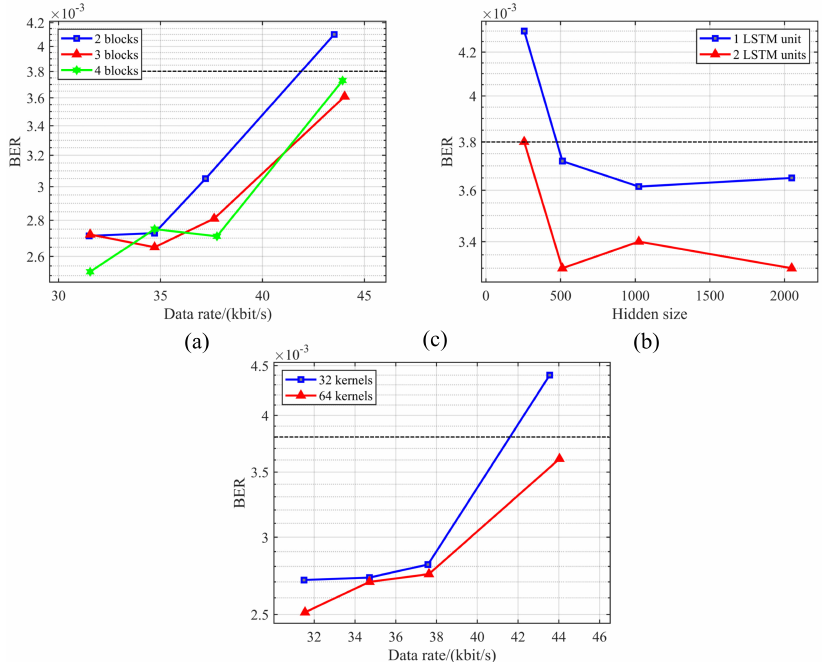
Figure 12. BER performance under different parameters of neural network structures. In addi- tion to the parameters investigated in each experiment, the other parameters are set as shown in Table 1. ( a ) Sensitivity of neural network performance to the quantity of blocks in encoder; ( b ) Un- der 46 kbaud/s, sensitivity of neural network performance to the quantity of hidden neurons and layers of LSTM-based equalizer; ( c ) Sensitivity of neural network performance to the quantity of convolutional kernels in